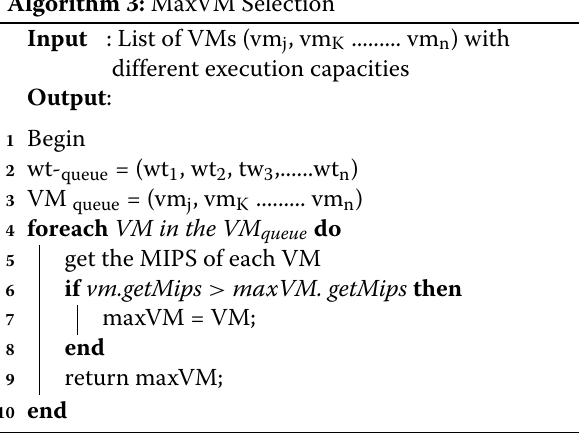
Algorithm 3: MaxVM Selection